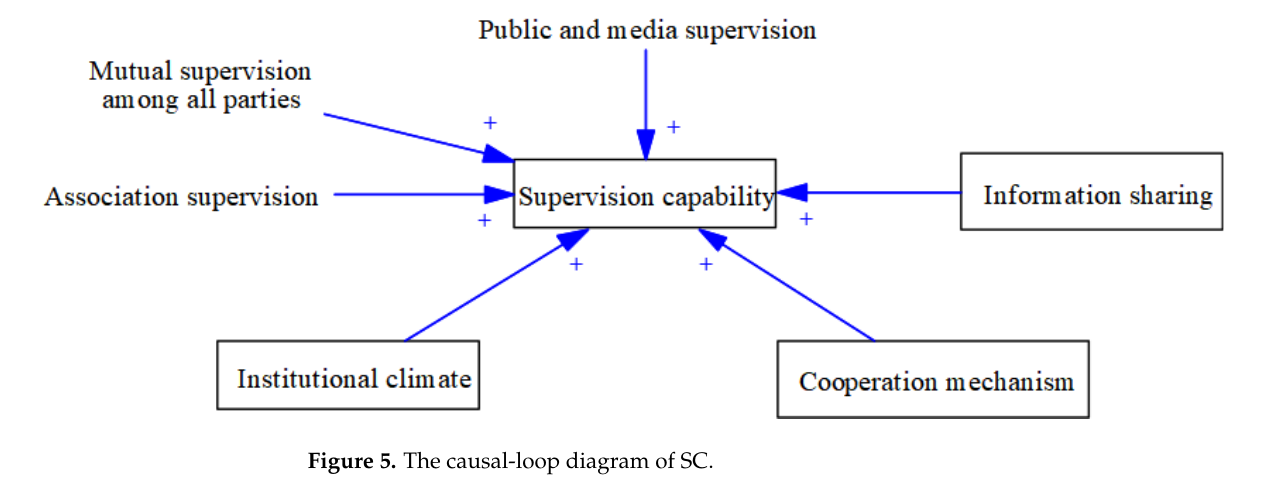
Figure 5. The causal-loop diagram of SC.